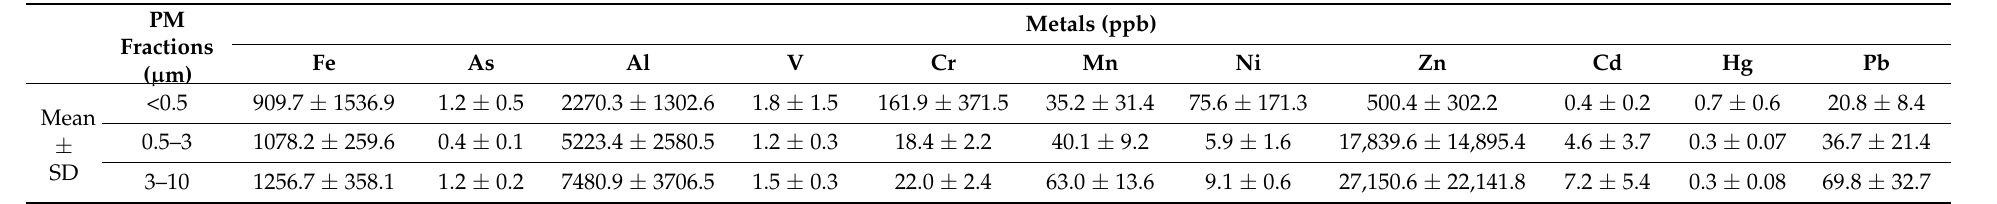
Table 3. Concentrations of metals measured in different fractions of